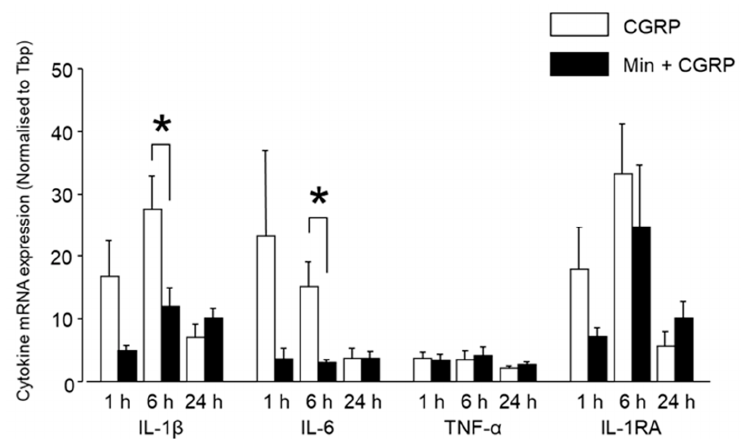
Figure 7. Differential mRNA expression of cytokines after IG CGRP and Min + CGRP administration. IG Min administered 1 h before CGRP decreased the expression of IL-1 β , IL-6 and IL-1RA after 1 and 6 h, compared to CGRP alone. After 24 h, there was a decrease in the expression of IL-1 β , IL-6 and IL-1RA in bothe the groups. Min administration had no effect on TNF- α expression. *: p < 0.05 with t -test. n = 5 rats were assigned to each group.